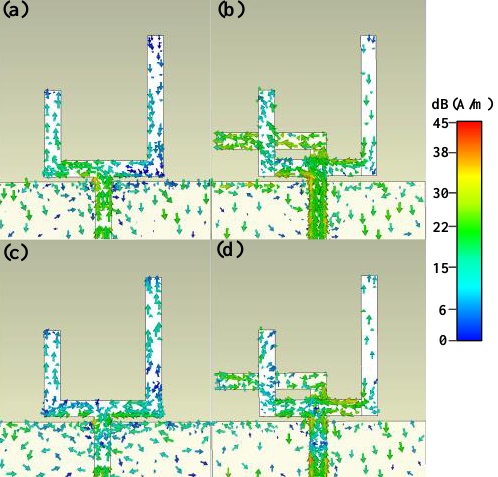
Figure 9. Simulation results of the surface current distributions. ( a ) ATPA at 2.4 GHz. ( b ) NTTPA at 2.4 GHz. ( c ) ATPA at 5.8 GHz. ( d ) NTTPA at 5.8 GHz.